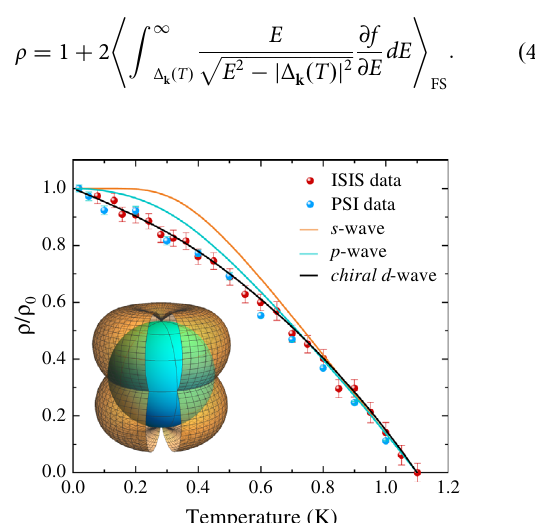
Fig. 2 Superconducting properties of LaPt 3 P by TF- μ SR measurements. TF- μ SR time spectra of LaPt 3 P collected at a 1.3 K and b 70 mK for sample- A in a transverse fi eld of 10 mT. The solid lines are the fi ts to the data using Eq. (2). c The temperature dependence of the extracted σ (left panel) and internal fi eld (right panel) of sample-A. The error bars show the standard deviations in the TF- μ SR measurements.